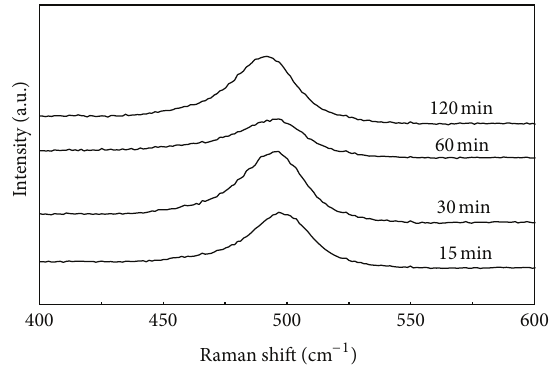
Figure 2: XRD patterns of specimens annealed for various dura- tions.